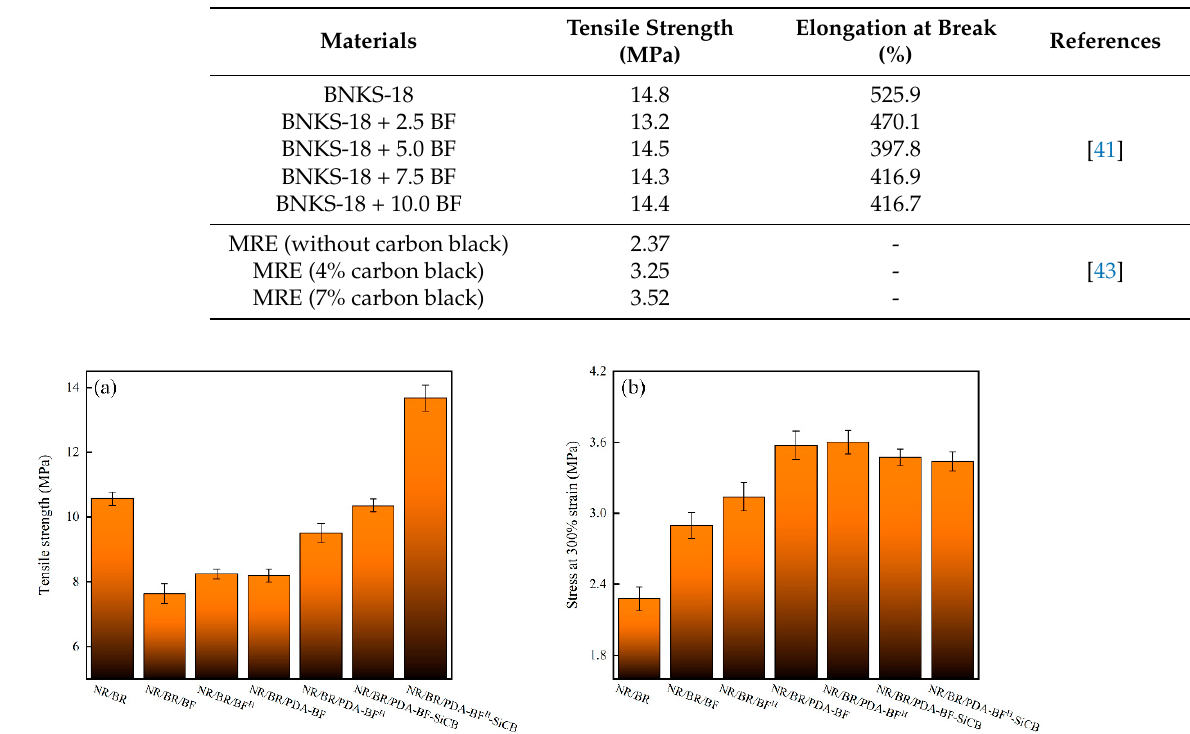
Table 3. Properties of elastomeric fiber composites.